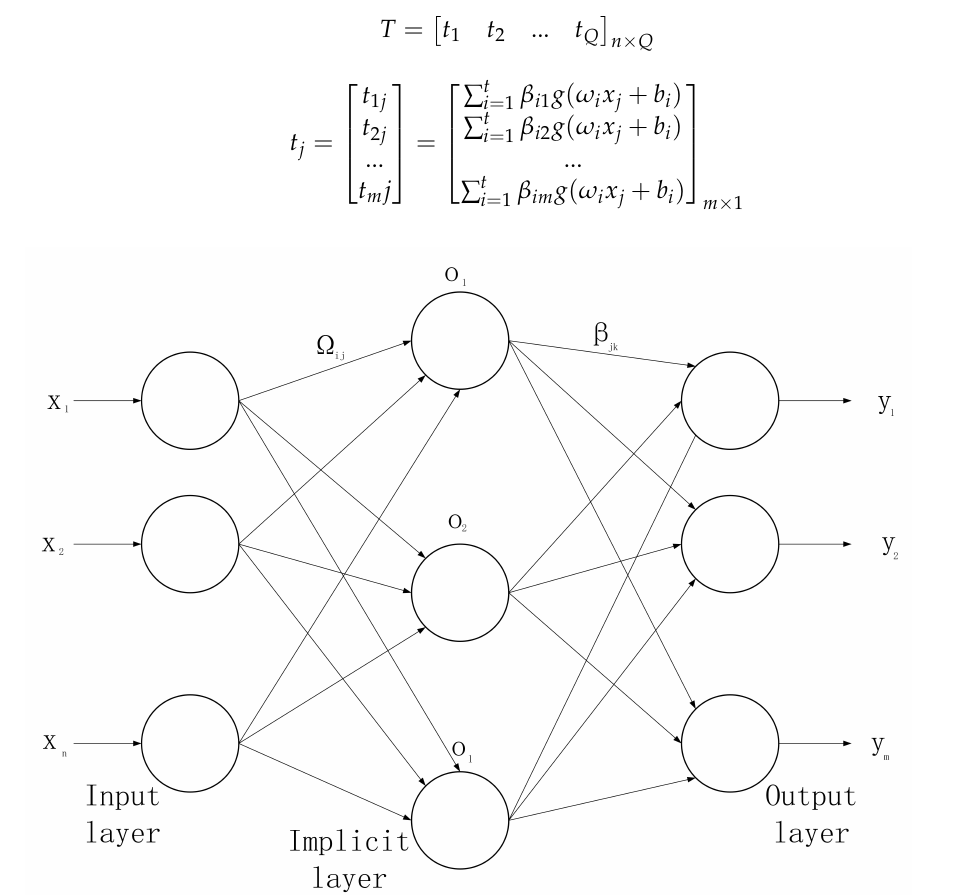
Figure 3. Extreme Learning Machine Network